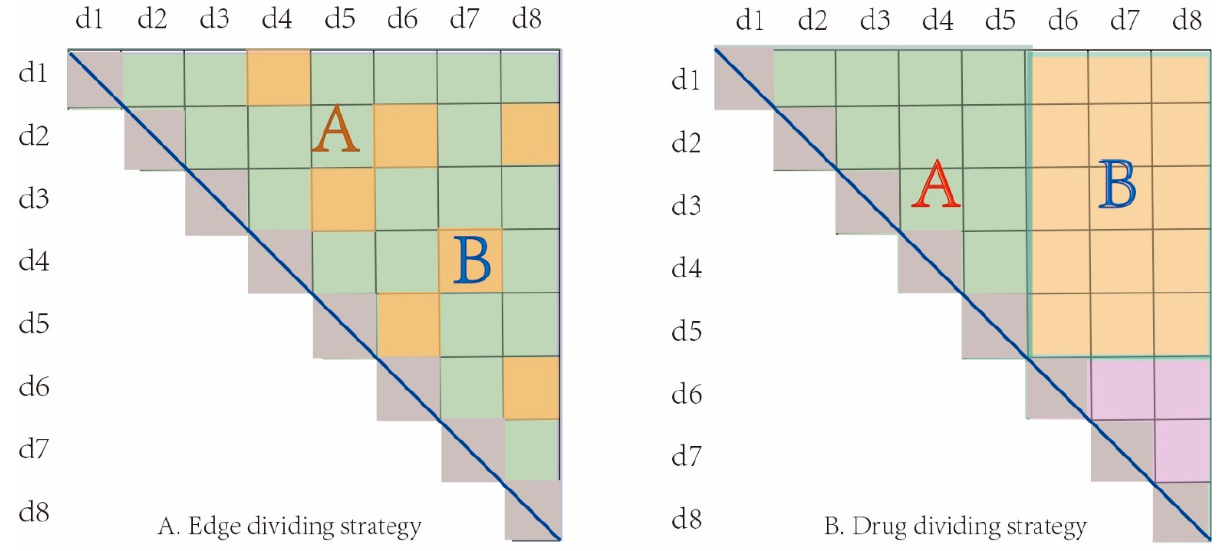
Figure 5. Two cross-validation strategies of sample partitioning. ( A ) Edge partition strategy, ( B ) Drug partition strategy.